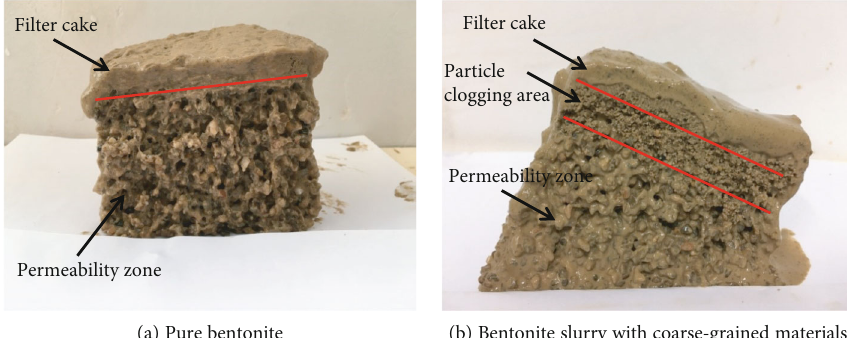
Figure 5: The permeability e ff ect of slurry in S3